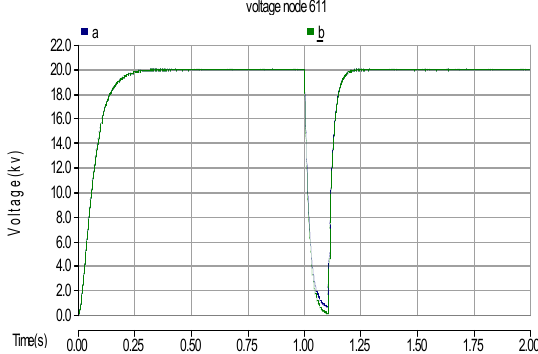
Figure 6. Voltage variations in bus 611 due to types of symmetrical short circuit faults in bus 671 and in uncompensated system: ( a ) three-phase fault; ( b ) three-phase to ground fault. Table 1. Domain of bus voltage due to different short circuits in the uncompensated system. Bus Number Short Circuit Type Single-phase to ground